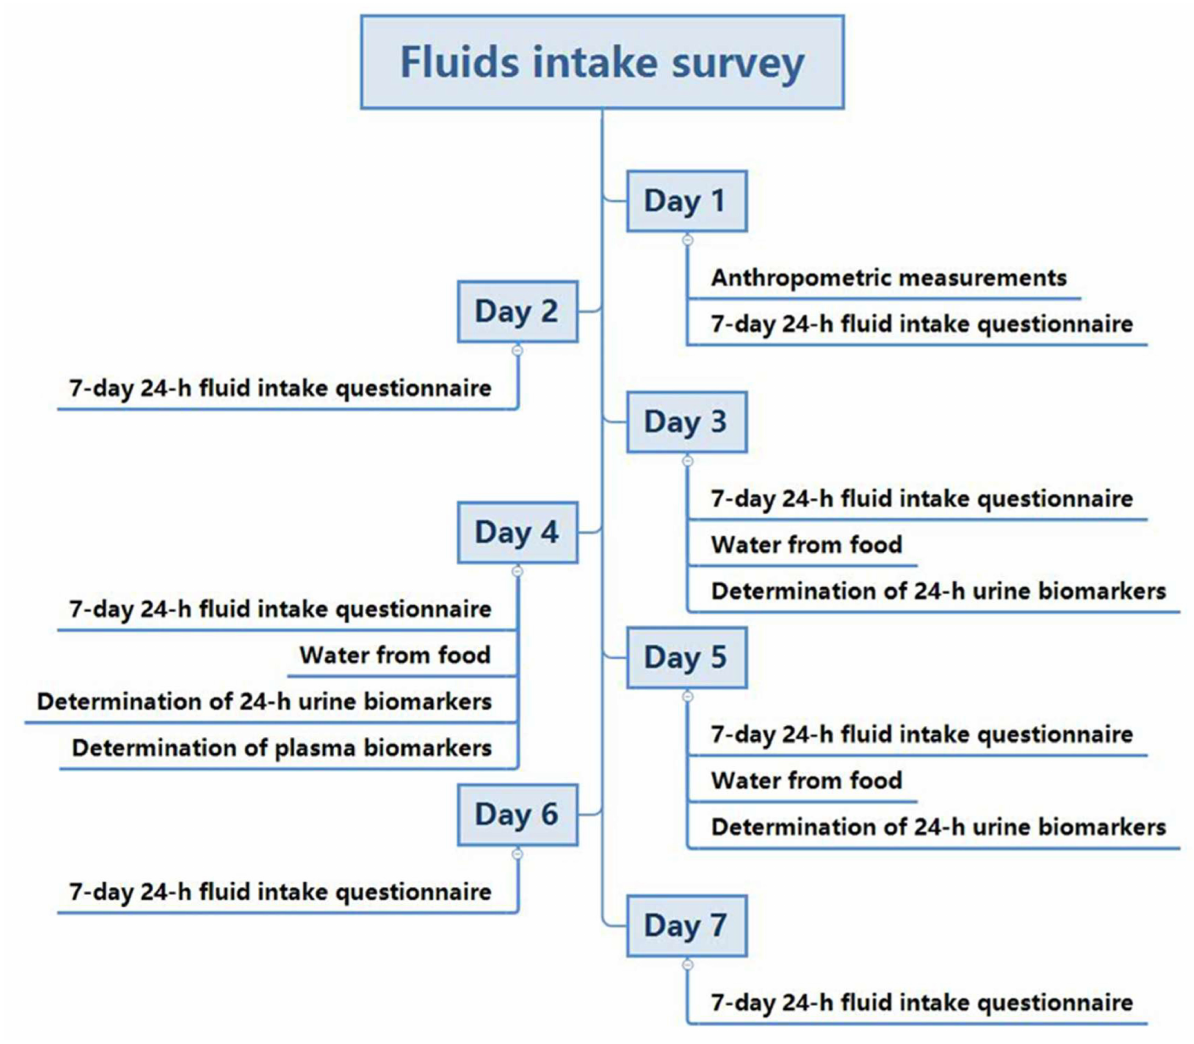
Figure 1. The study